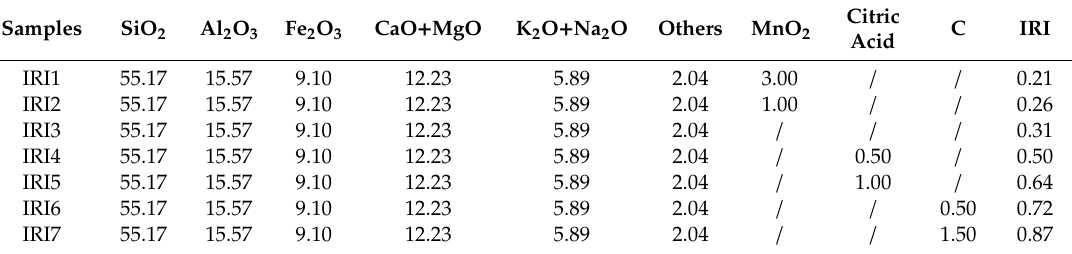
Table 1. Chemical compositions of basalt mixture (wt